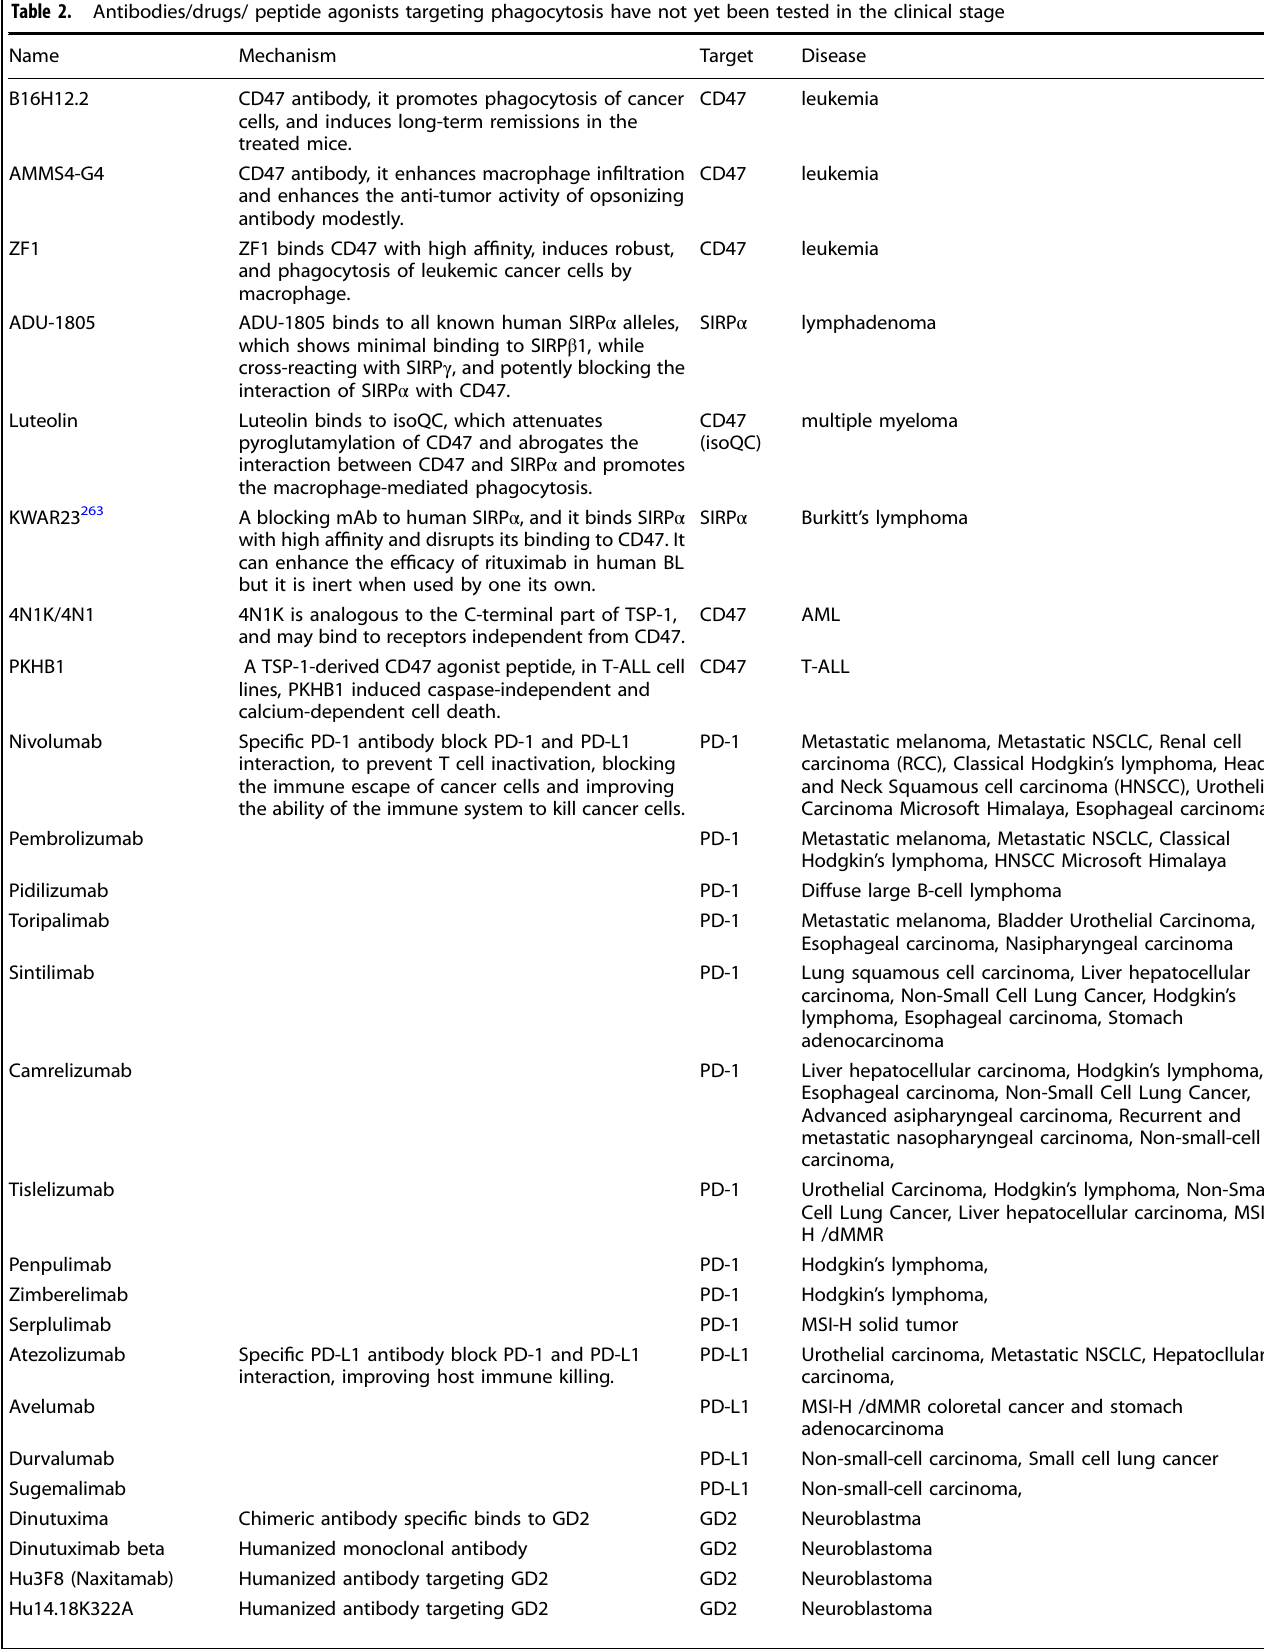
Table 2. Antibodies/drugs/ peptide agonists targeting phagocytosis have not yet been tested in the clinical stage